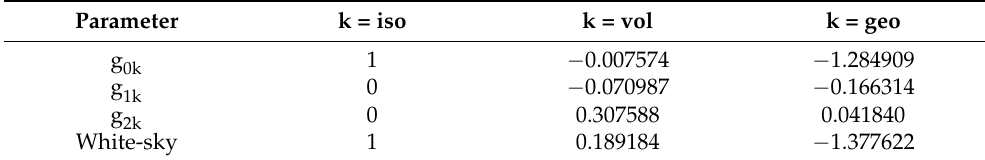
Table 5. Coefficients for calculating